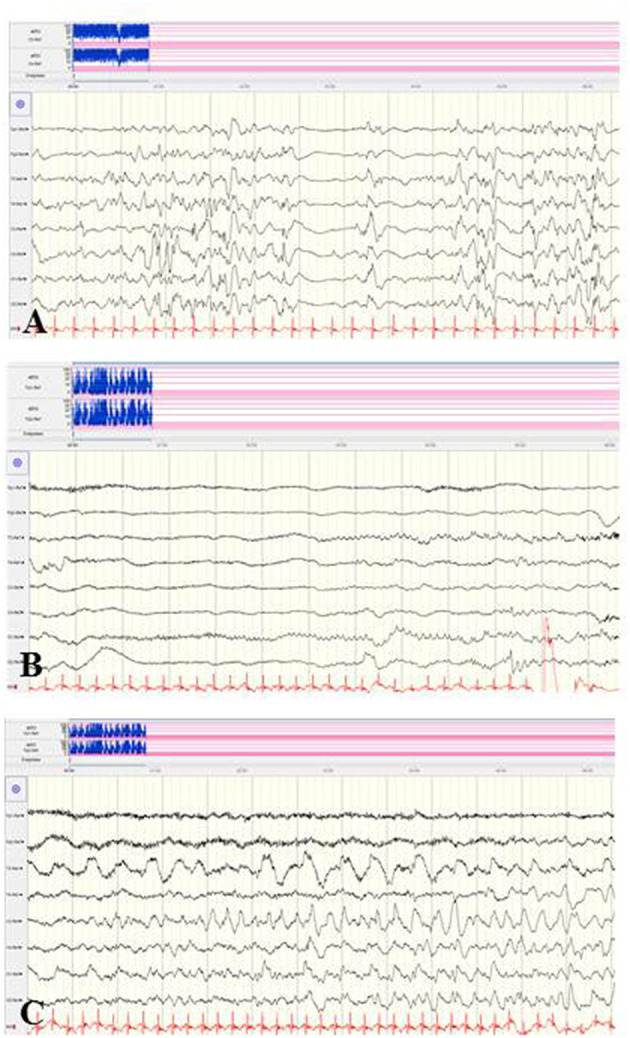
EEG findings of a female neonate with seizure onset in the first day of life caused by a de novo duplication of the SCN gene cluster of chromosome 2q24. (A) Suppression burst during asleep and awake periods. (B,C) Ictal pattern was initial suppression followed by focal epileptic discharges and continuously suppressed background. (Calibration 100 μV/cm, low-pass 30 Hz, high-pass 0.5 Hz).